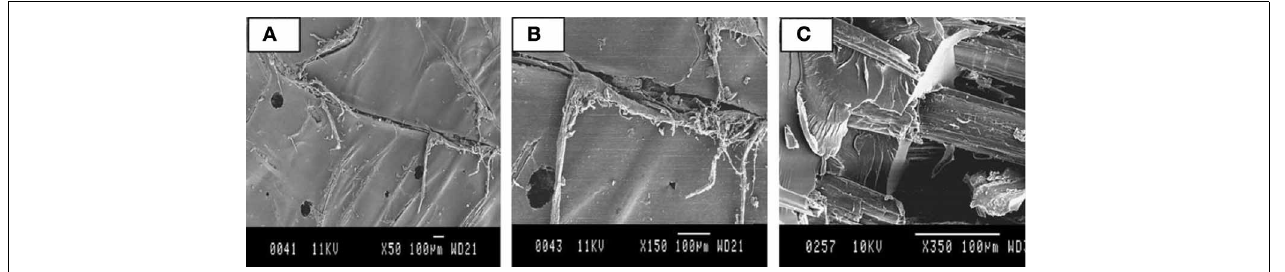
FIGURE 4 | (A) Matrix cracking, (B) Fracture running along the interface, (C) Fiber/matrix debonding due to attack by water molecules (Dhakal et al., 2007).